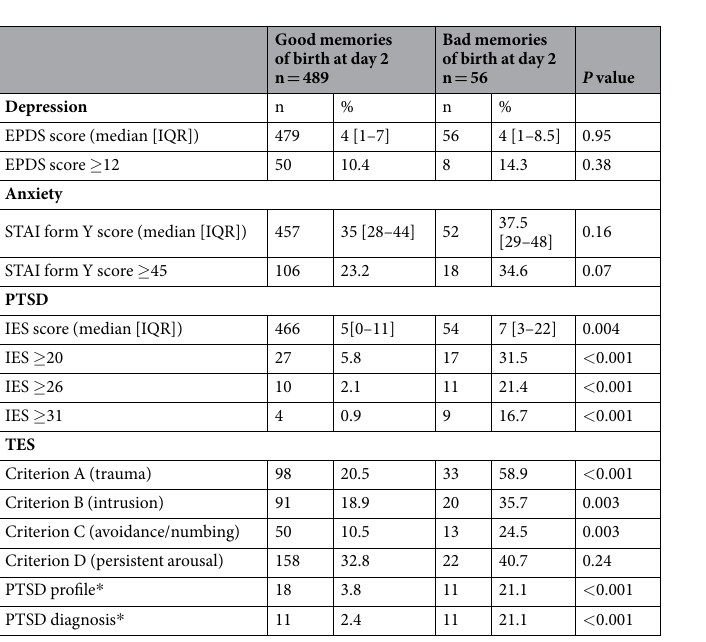
Table 5. Association between bad memories of birth in immediate postpartum period (day 2) and psychological status at one year. EPDS, Edinburgh Postnatal Depression Scale; STAI, State-Trait Anxiety Inventory; PTSD, post-traumatic stress disorder; IES, Impact of Event Scale; TES, Traumatic Event Scale. * The term PTSD diagnosis is used when all diagnostic criteria of the DSM-IV (A, B, C, D, E, F) on the TES scale were met. The term PTSD profile is used when all symptom criteria (B, C and D) 1 were met, but some other criteria (A, E or F) were missing 4